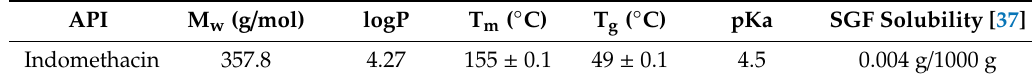
Table 1. Physicochemical properties of model drug.